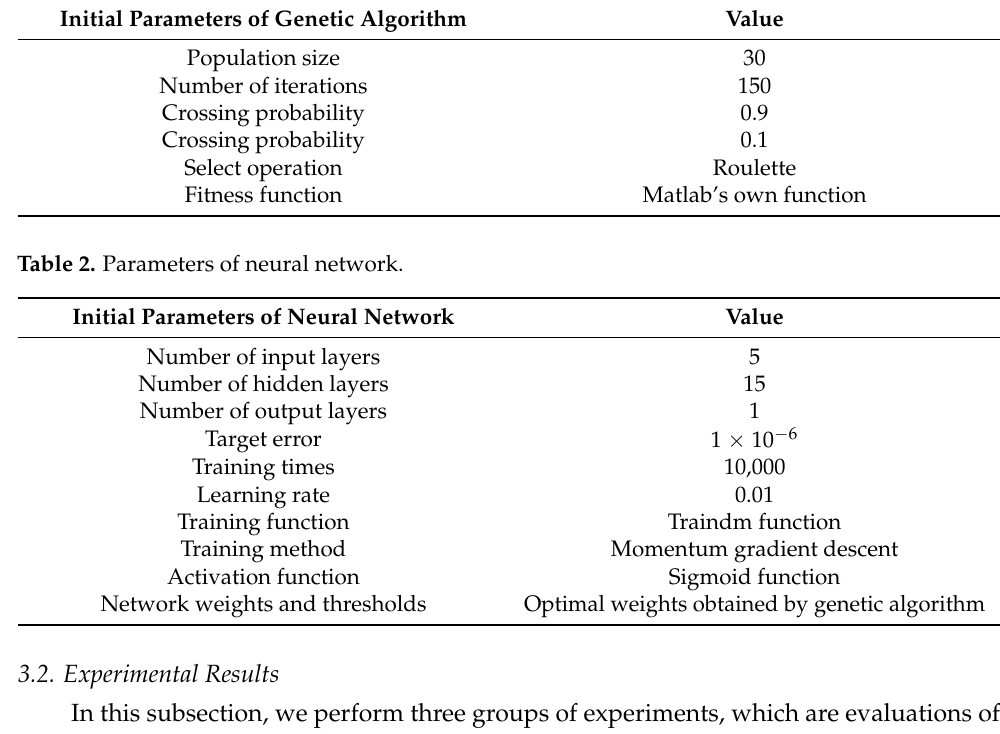
Table 1. Parameters of genetic algorithm.